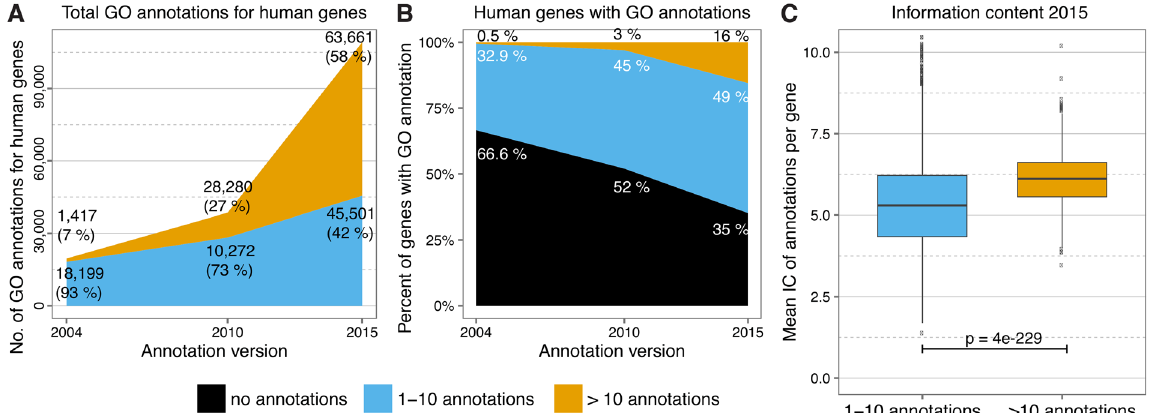
Figure 2. Gene ontology annotation developments, human genome, 2004 to 2015. (A) Number of GO annotations and their distribution across poorly characterized (blue) and well-characterized (gold) human genes over time. ( B ) GO annotation status of the human genome (2004 vs. 2015). Genes are classified by annotation status in uncharacterized (black) vs. poorly characterized (blue) vs. well characterized (gold). Only terms relevant for enrichment analysis results were counted (excluding: IEA, ND and cellular component). C) Comparison of the average information content (IC) of poorly characterized vs. well-characterized human genes in 2015 shows that the mean IC for genes with more annotations was higher (p = 4e-229). The same difference was observed in 2004 (p = 2e-19, Supplementary Figure